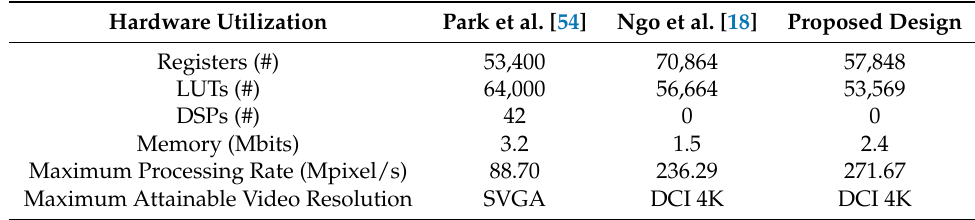
Table 12. A comparative evaluation with other hardware